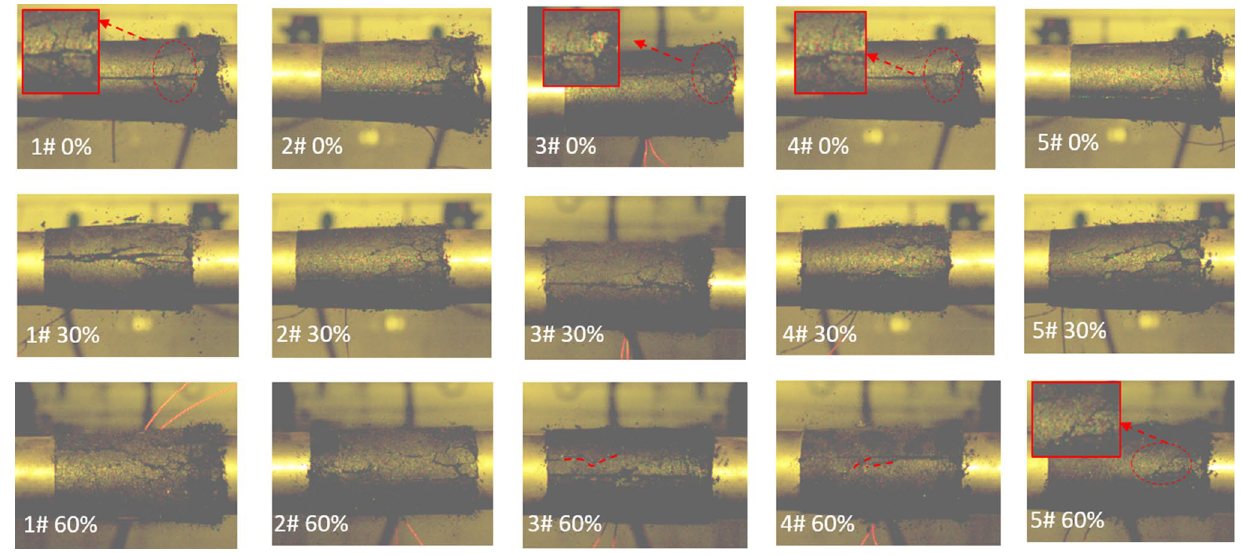
Fig. 6 Effect of coal sample immersion on transformation of stress